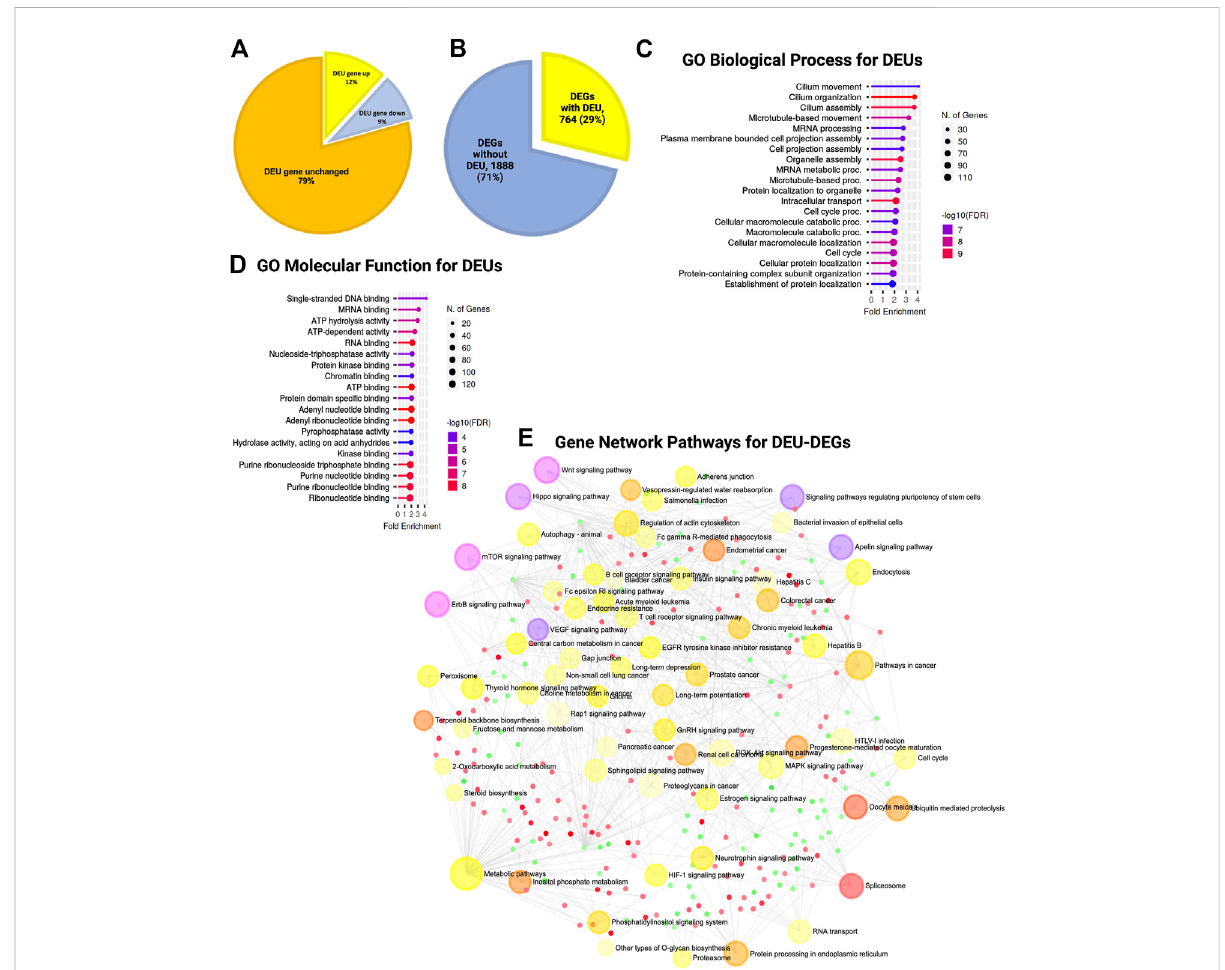
FIGURE 5 TSK de fi ciency disrupts the splicing of genes associated with ciliary function, transcriptional regulation, and developmental pathways. (A) Percentage distribution of DEU genes with differential gene expression. The color of the pi-chart slice corresponds to its annotation. (B) Percentage distribution of DEGs with DEU. (C) Top 20 GO biological process categories signi fi cantly enriched in DEGs with DEU. The blue to red gradient of the lollipop indicates the-log FDR value. The length of the lollipop indicates fold enrichment. The size of the lollipop tip indicates the number of positive gene hits in relevant categories. (D) Top 20 GO molecular function categories signi fi cantly enriched in DEGs with DEU. (E) Gene set enrichmentnetworkofdifferentiallyexpressed genesthathaveDEU usingsigni fi cantly enrichedKEGGpathway functional categories ( p < 0.05).The larger nodes represent enriched pathway gene sets. The smaller nodes correspond to individual genes. The size of the node is proportional to the number of relevant genes in the set. The p -value of the node is indicated by the yellow to red gradient. Essential developmental signaling pathways are indicated by the violate gradient, with darker shades indicating higher p values. Edges (gray lines) indicate shared genes between two nodes. The network is represented as a bipartite